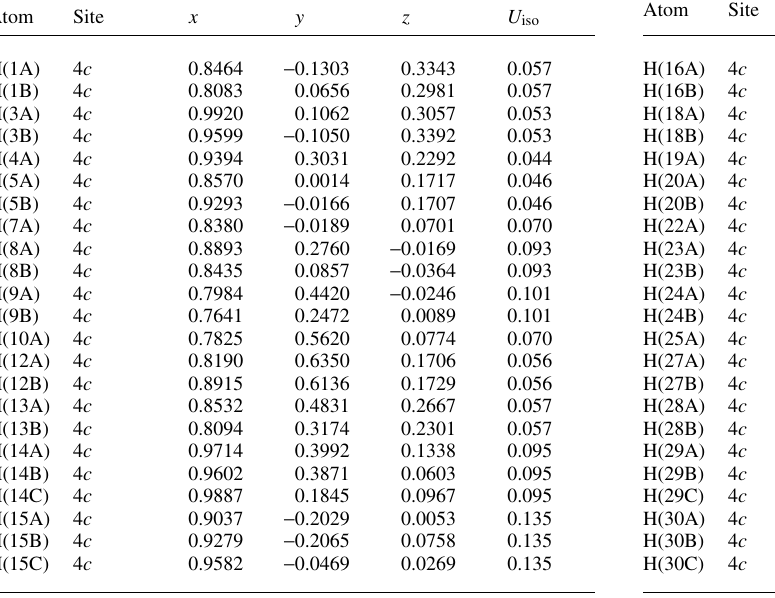
Table 2. Atomic coordinates and displacement parameters (in Å 2 )